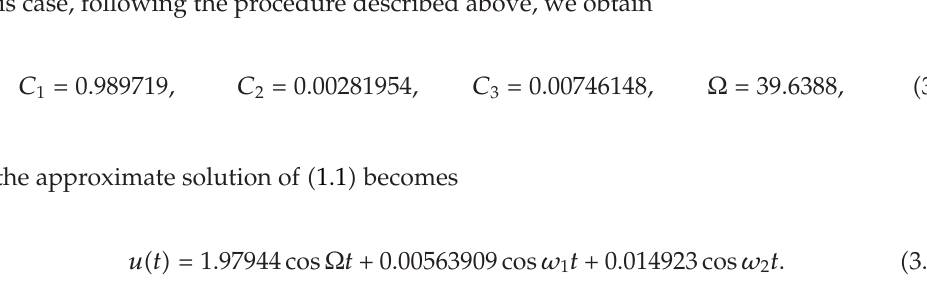
(cid:9) 2 . 5, ω (cid:9) 1 . 5, f (cid:9) 1 2